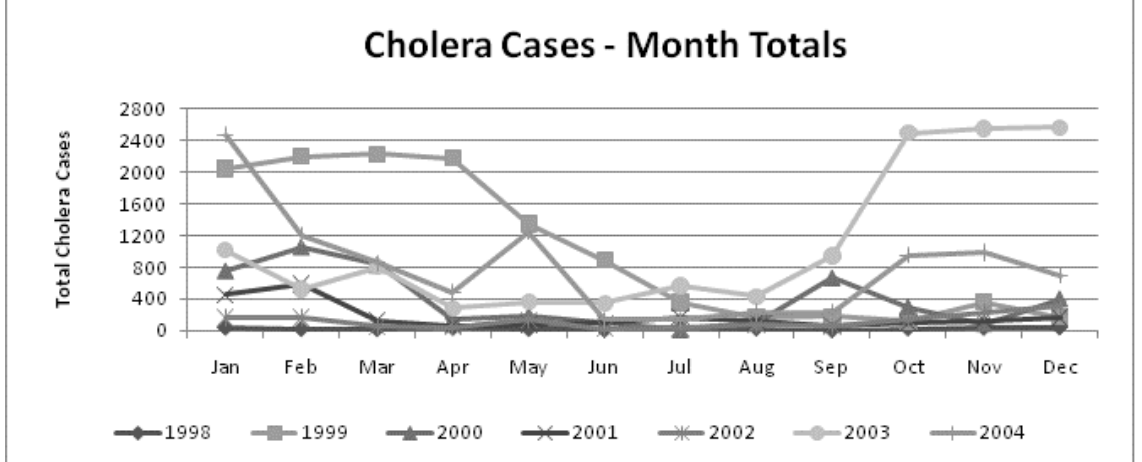
Figure 1. Seasonal distribution of cholera cases in